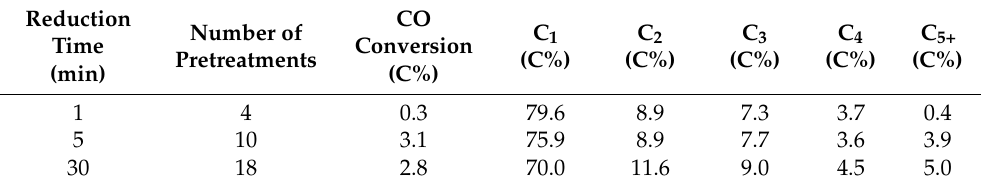
Table 1. Conversion and selectivities at the end of each experiment in Series 1 with constant reduction time of the cobalt foil (see Figures 1 and 2). The pretreatment involved calcination, reduction, and then CO hydrogenation. Time on stream for each FT test: 70